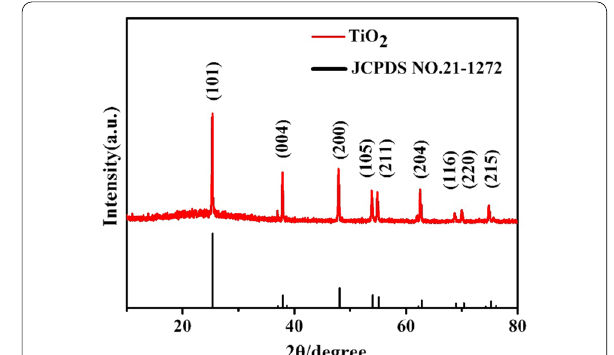
Fig. 3 XRD pattern of TiO2